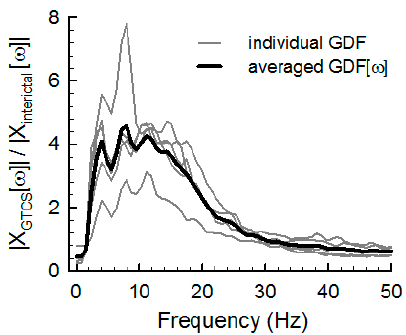
Figure 4. Example of the individual GTCS-dependent spectral weight functions (GDFs).